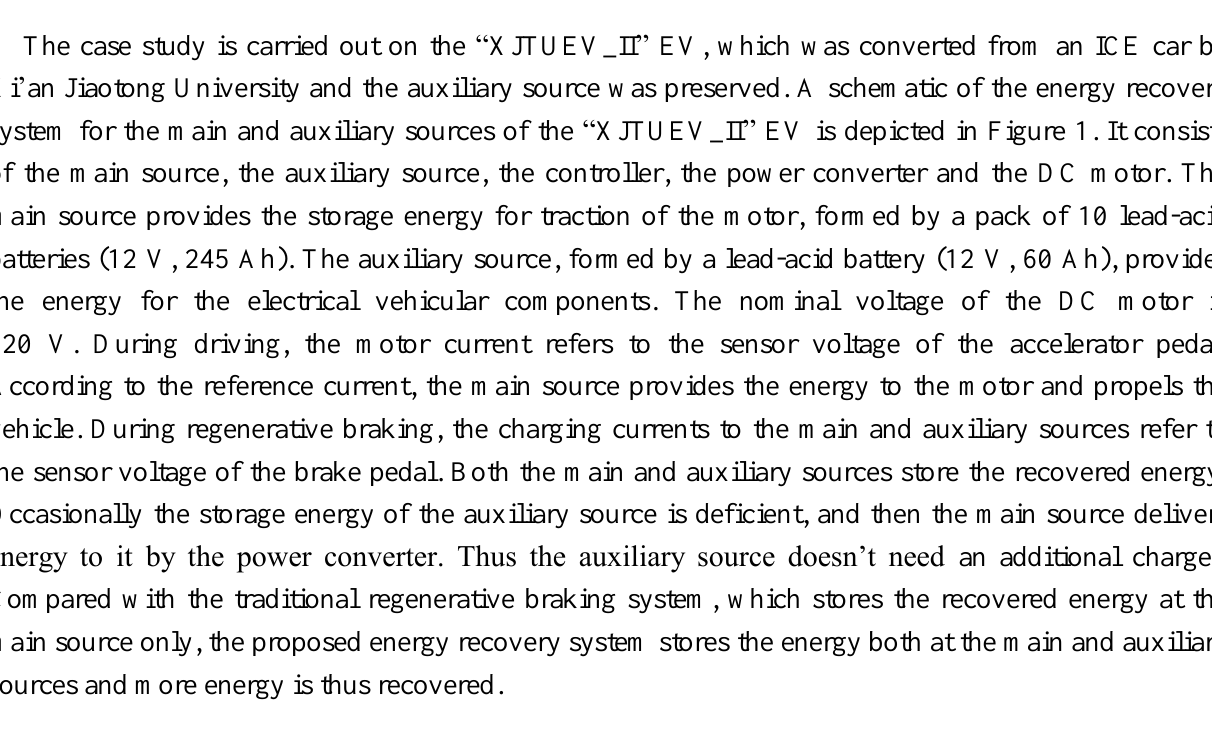
Figure 1. The schematic of the energy recovery system for the main and auxiliary